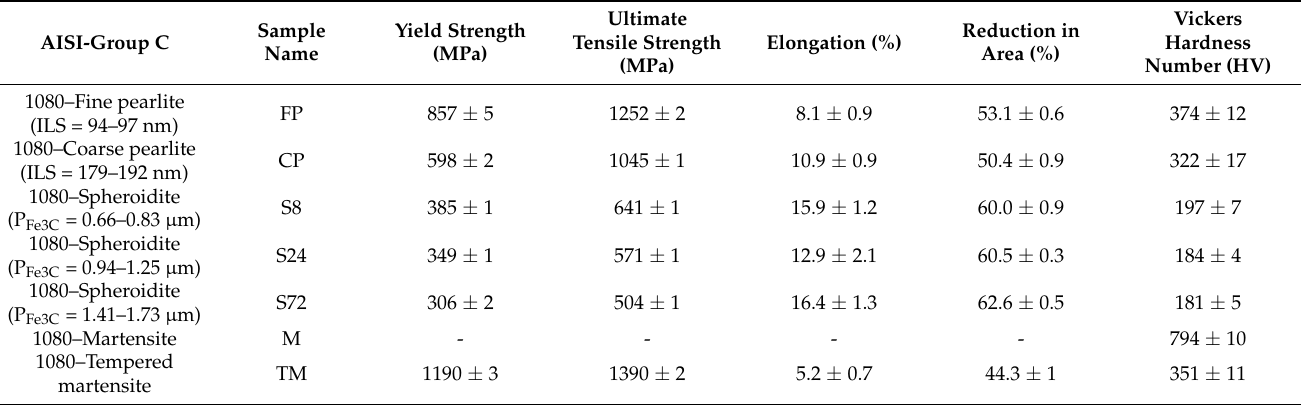
Table 6. Mechanical properties of the various microstructures of group C obtained from AISI 1080